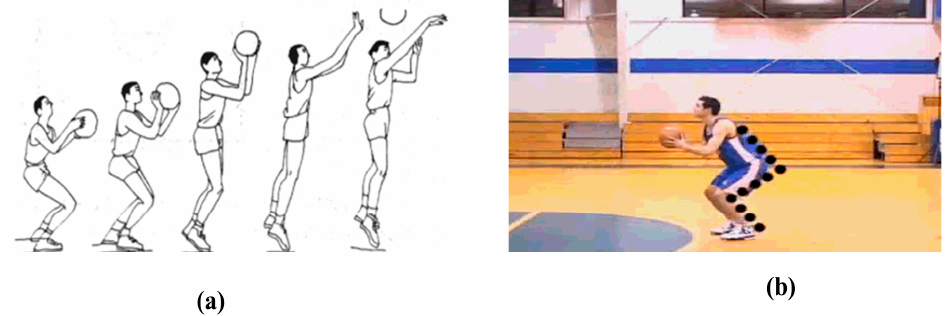
Figure 11. Shooting action video. ( a ) Preprocessing stage of human motion video; ( b ) action recognition results.